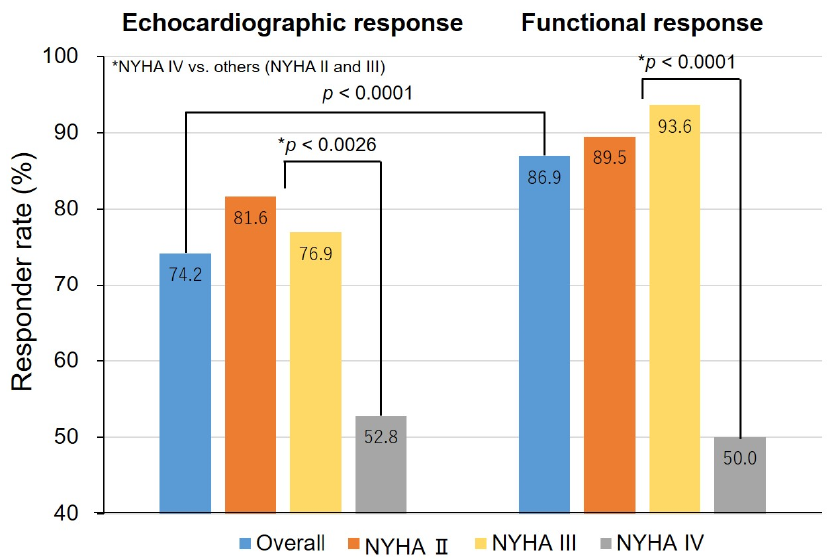
Figure 1. Responder rates, overall and by the New York Heart Association (NYHA) classification. p -values were calculated to assess differences among patients with NYHA class IV versus NYHA class II or class III by response criteria. * p -value indicates the difference between NHYA IV versus others (NYHA II and III).